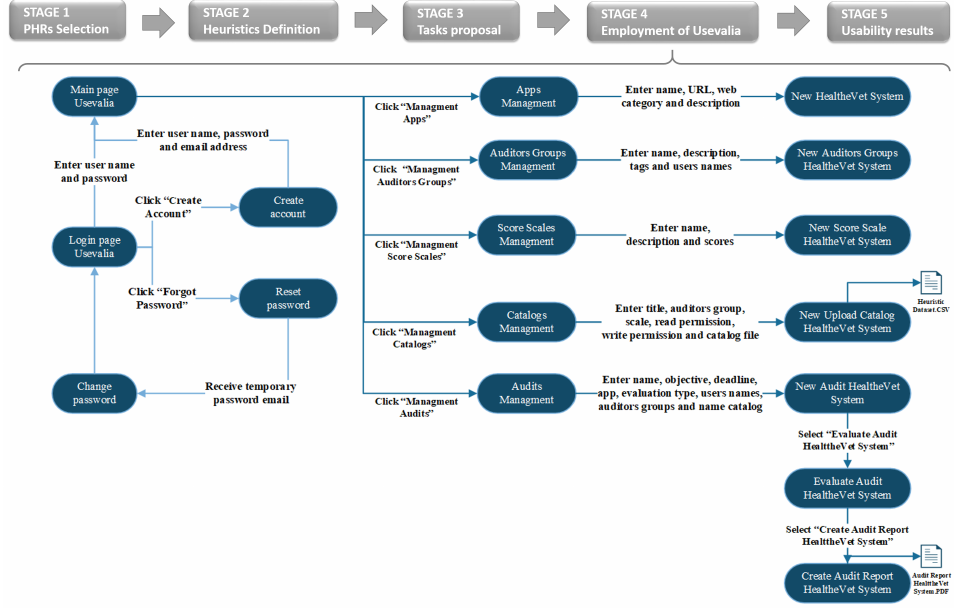
Figure 3. Workflow followed in the usability